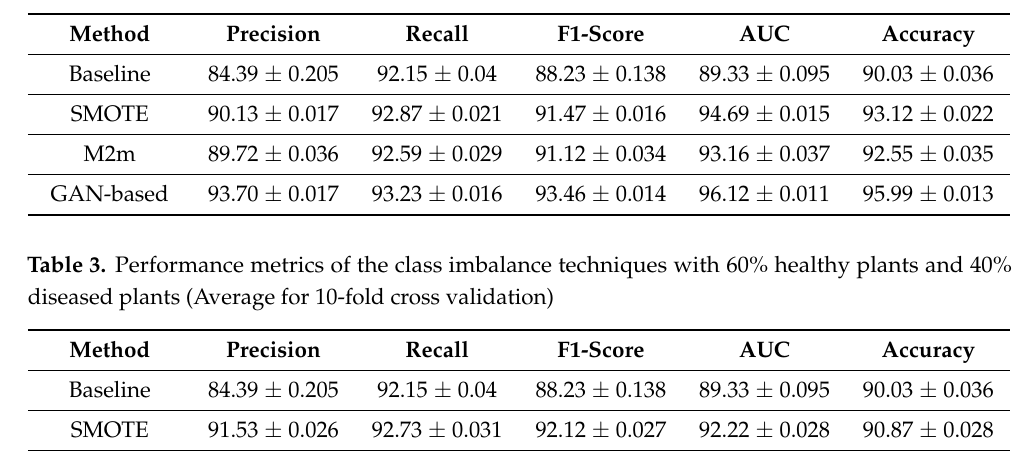
Table 2. Performance metrics of the class imbalance techniques with 50% healthy plants and 50% diseased plants (Average for 10-fold cross validation).